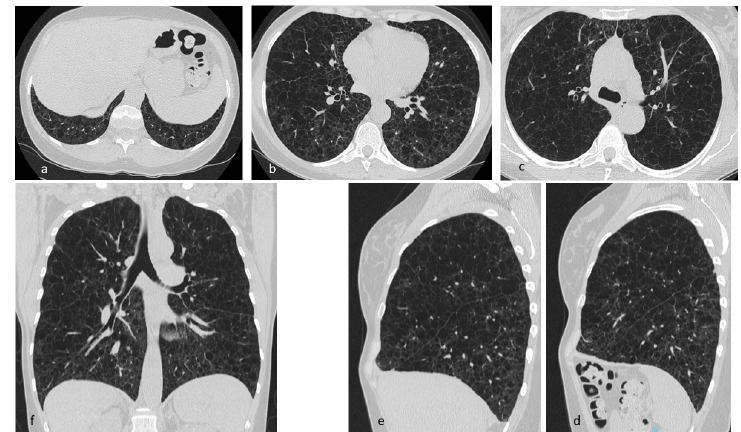
Figure 6. LAM: multiple cysts in pulmonary parenchyma with diffuse distribution ( a , b , c ), including apices, basal regions and costophrenic angles ( d ). Multiplanar reconstructions (MPR) in the sagittal ( d , e ) and coronal ( f ) plane.